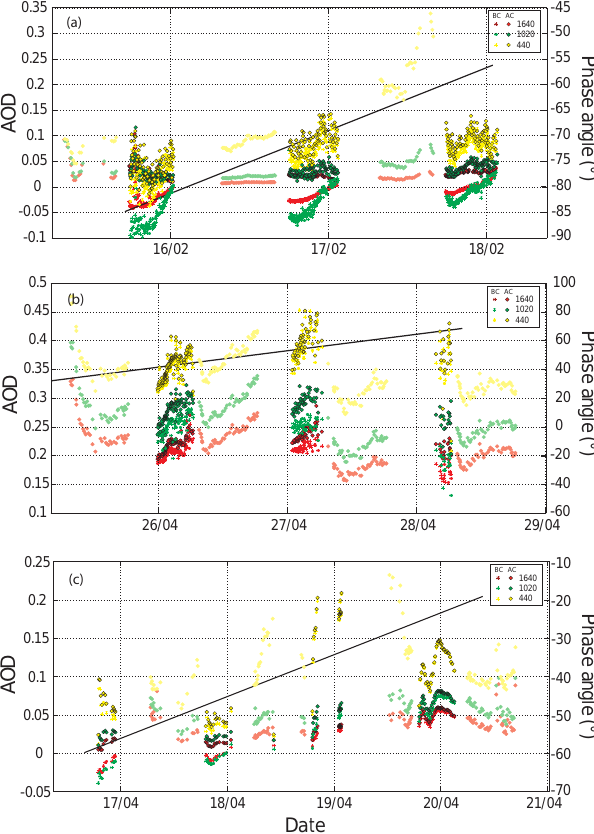
Figure 8. AOD before correction (BC) and after correction (AC) at (a) Carpentras, (b) Dakar and (c) Lille in 2016. Opaque colors represent daylight data. The black line and right y axis correspond to the phase angle evolution in this